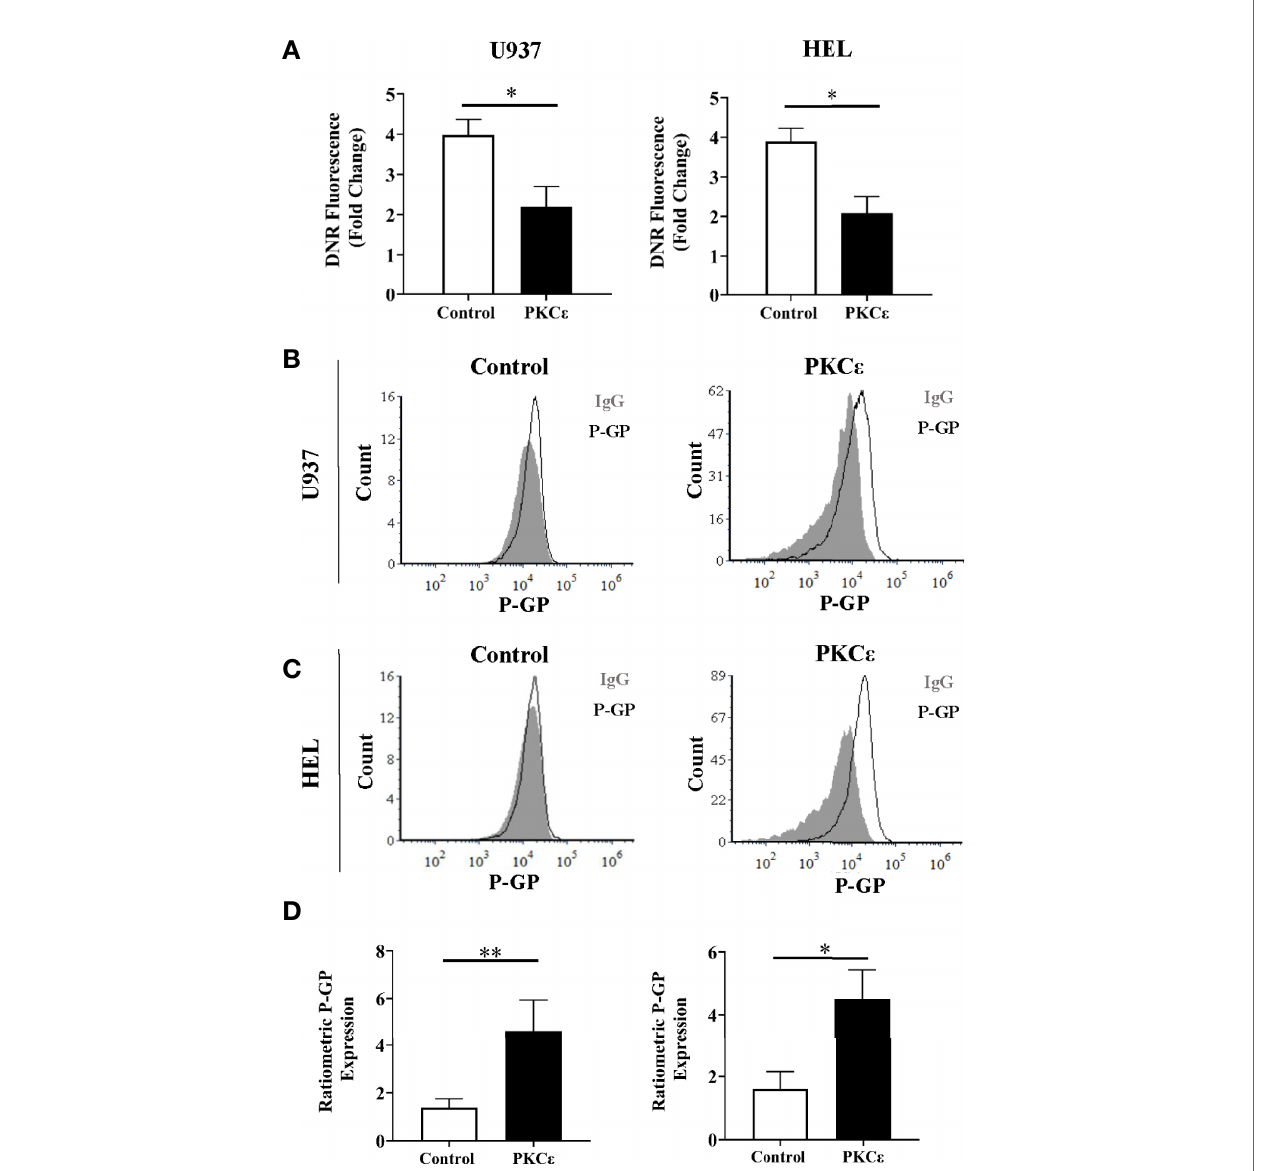
FIGURE 5 | PKC ϵ overexpression promotes P-GP upregulation in AML cell lines. (A) Bar charts showing the DNR fl uorescence [fold change relative to cells treated with the vehicle control, (PBS)] of U937 (left) and HEL cells (right) transduced with the control and PKC ϵ overexpression constructs, following 2 hours of treatment with 100nM DNR (n=4); data represents mean+1SD; * p<0.05 using paired t-test. (B, C) Representative histograms showing P-GP expression (MFI) in U937 and HEL cells transduced with the control and PKC ϵ overexpression constructs. P-GP expression was detected by fl ow cytometry using the CD243-APC